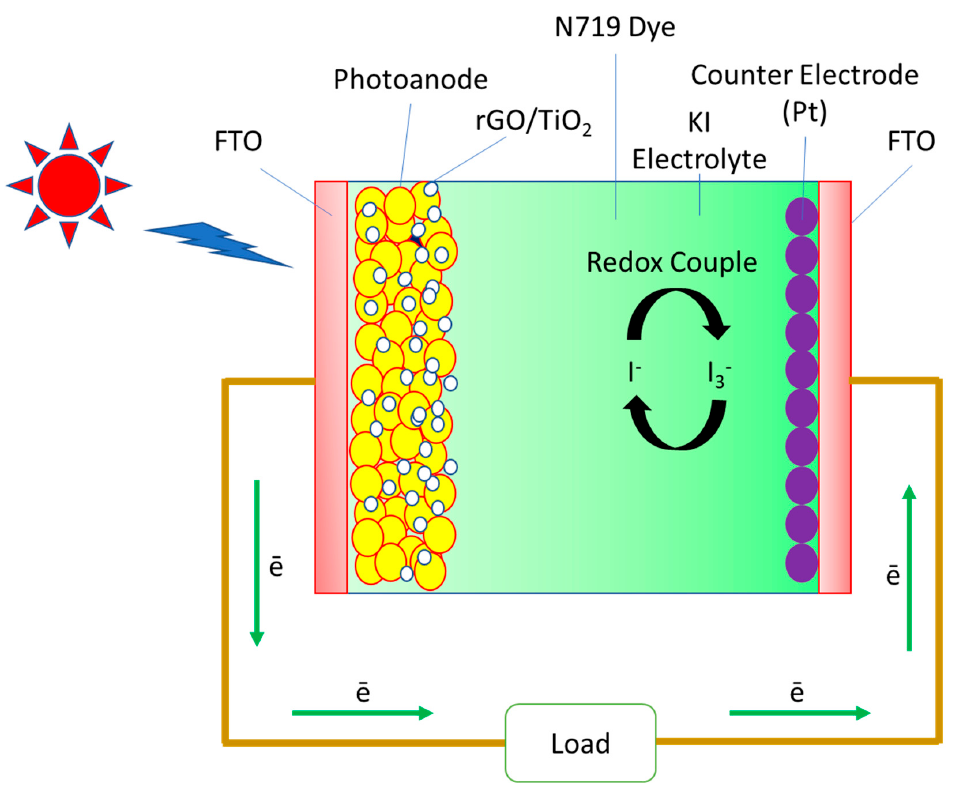
Figure 3. DSSCs schematic diagram of rGO-TiO 2 nanocomposite photoanode.